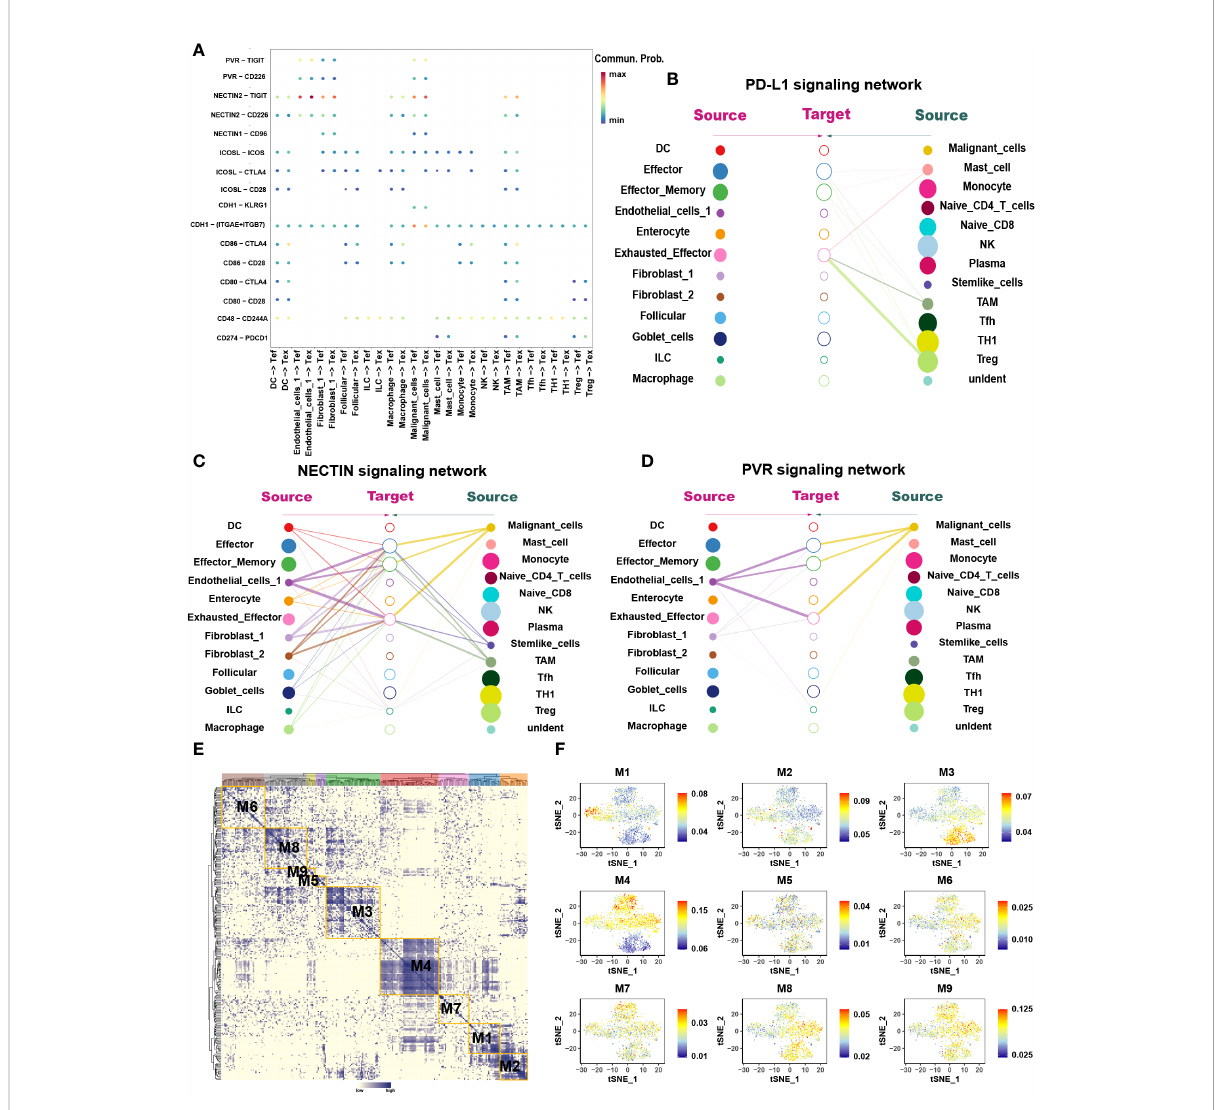
FIGURE 3 The interaction network and transcription regulatory network of CD8+ T cells. (A) Summary of selected ligand-receptor interactions between CD8+ T cells and TME-in fi ltrated cell types detected by CellChat. P-values are represented by the size of each circle. The color gradient indicates the level of interaction; blue and red colors correspond to the smallest and largest values respectively. (B – D) Hierarchical plot showing the inferred intercellular communication networks for PD-L1 (B) , NECTIN2 (C) , and PVR (D) signaling, respectively. The interactions are divided into sources and targets and were labeled by solid circle and hollow circle, respectively. The circle sizes in the hierarchical plot are proportional to the number of each cell type and the edge width represents the communication probability. (E) Heatmap of 9 identi fi ed regulon modules based on the regulon CSI matrix. (F) t-SNE map for all CD8+ T cells based on the regulon activity scores (RAS) of the respective regulon